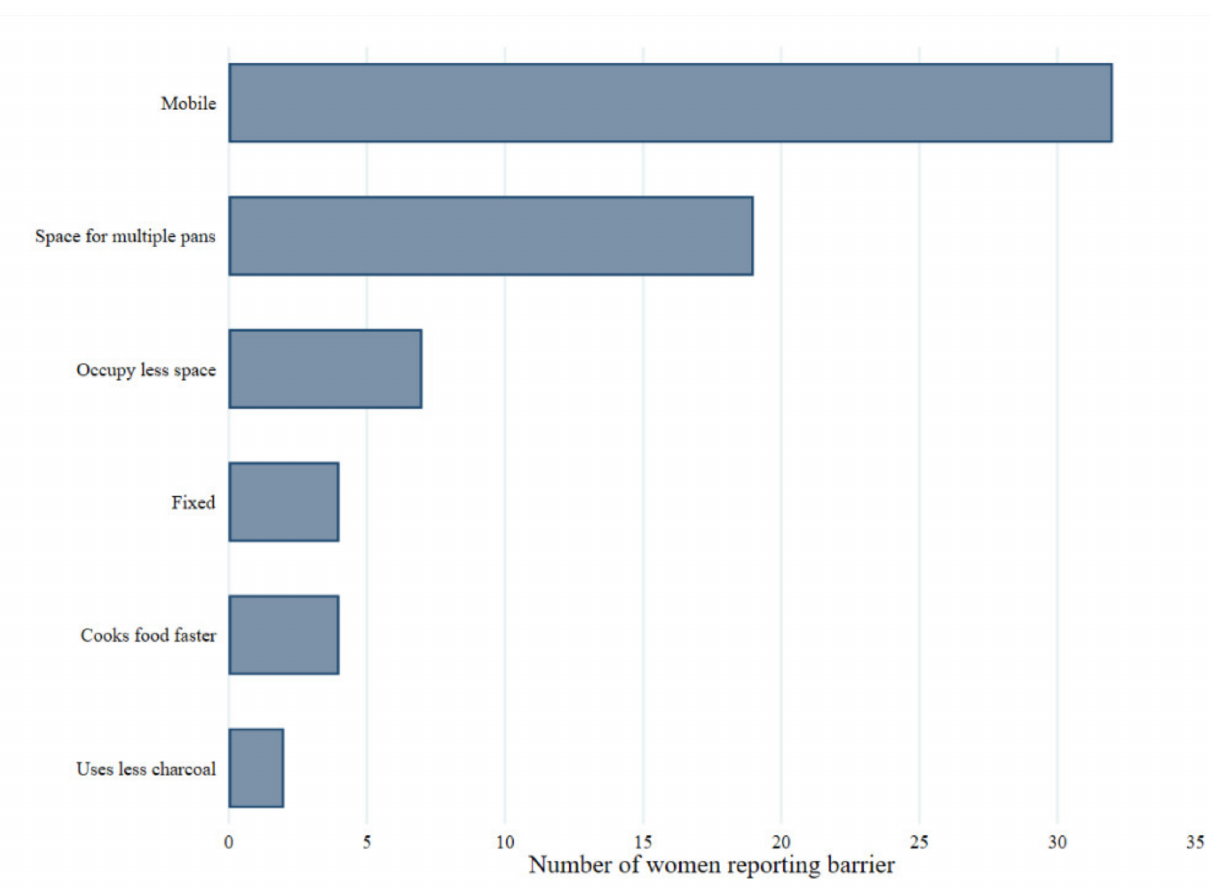
Figure 5. Participant responses for desired features of improved cookstove. Women participating also expressed some concerns regarding ICS, these included cost (14%), the fact that it still released smoke (6%), it would still contribute to health (11%) and safety issues (3%), as well as impact on cooking time for foods